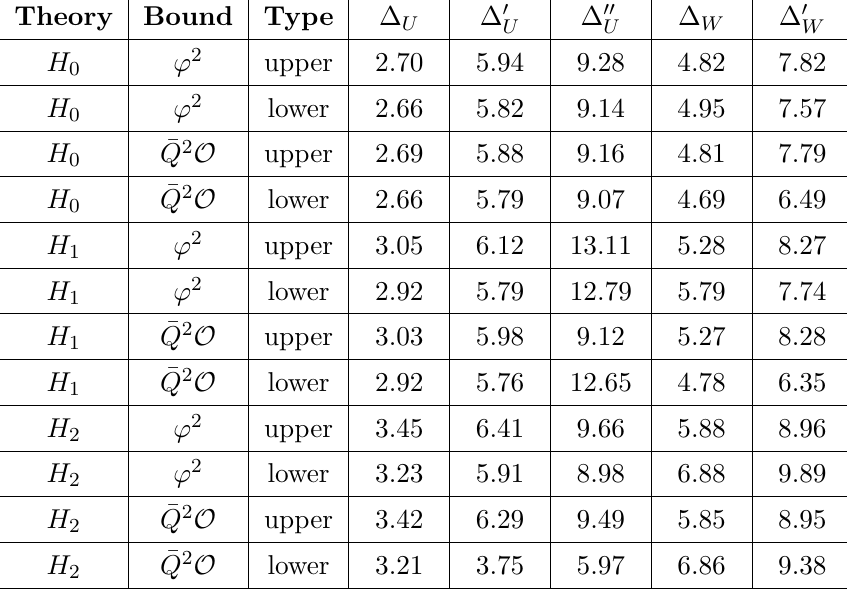
Table 8 . Approximate spectrum from OPE bounds at Λ = 50